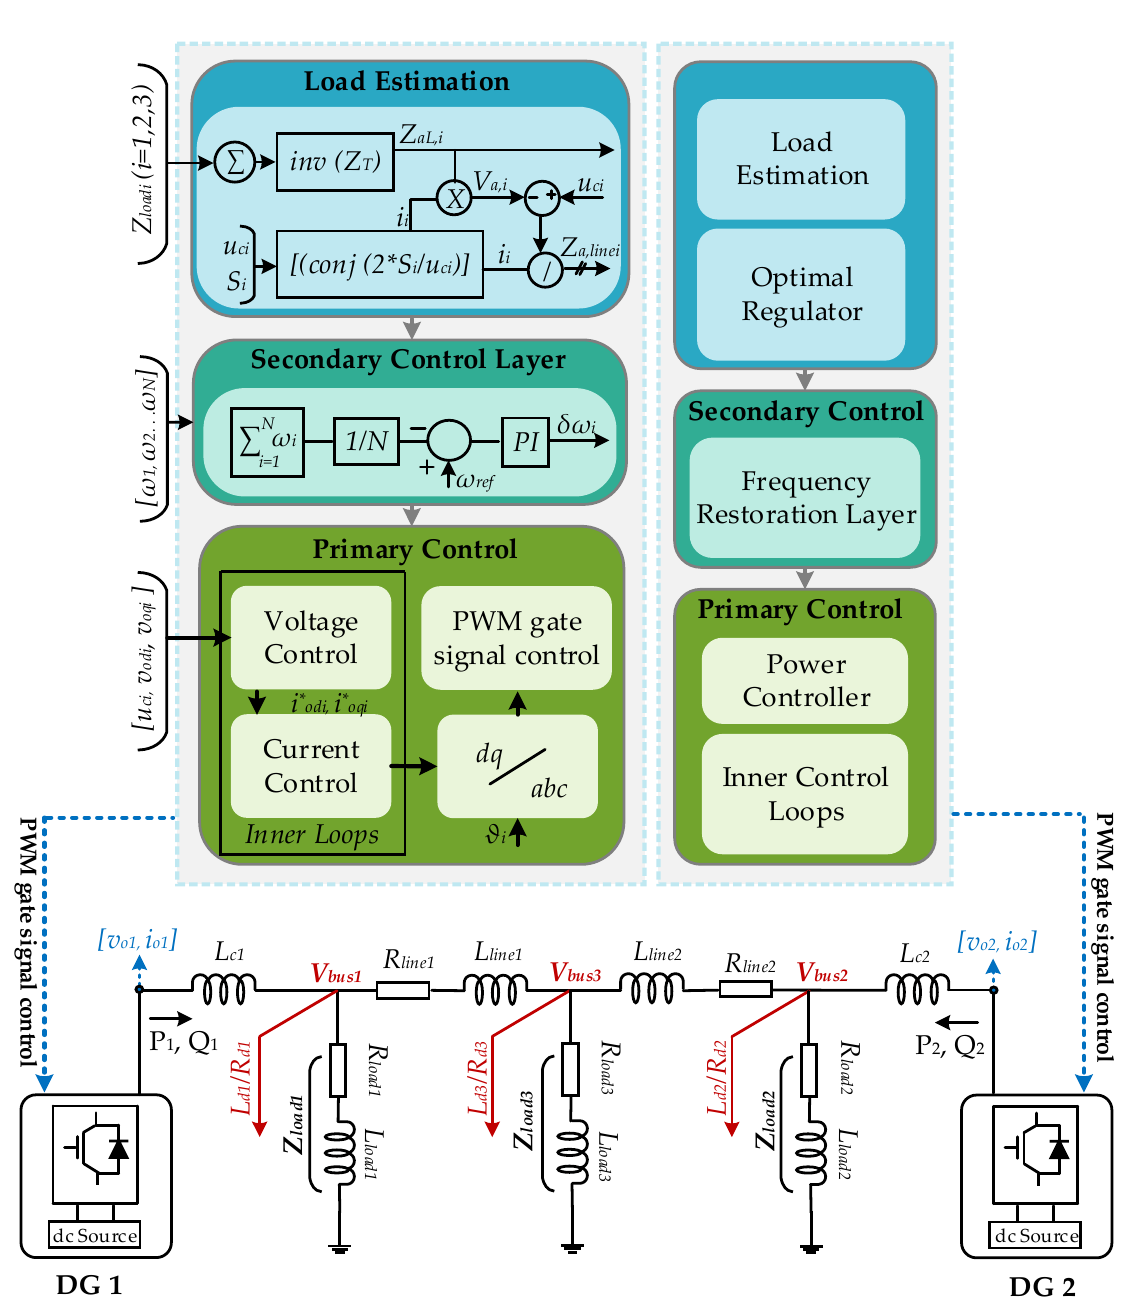
Figure 2. MG power network model and proposed control strategy. Table 1. System parameters for simulation and experiment.